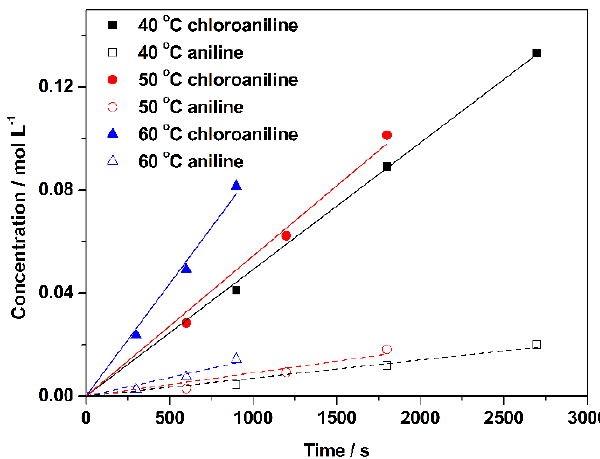
Figure 3. Rate of formation of 4-chloroaniline (CAN) and aniline (AN) during the hydrogenation of 4-chloronitrobenzene (CNB) over a 1% AuPd/TiO 2 (M Im ) catalyst at different temperatures. Reaction conditions: 4-chloronitrobenzene: 10 mmol, ethanol: 16 mL, catalyst: 12.5 mg, H 2 pressure: 3 bar.